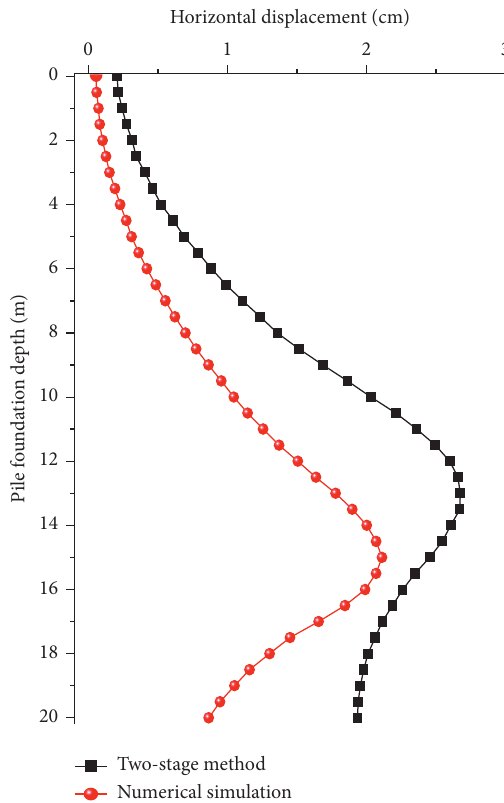
Figure 17: Horizontal displacement of pile in clay.